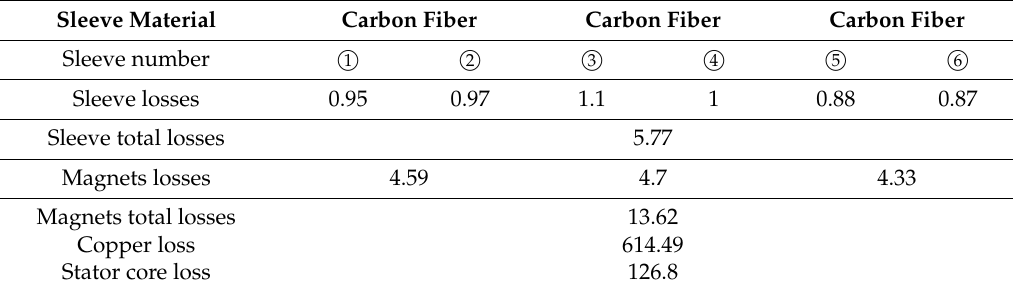
Table 8. Losses in different parts of PMSM under Design 3